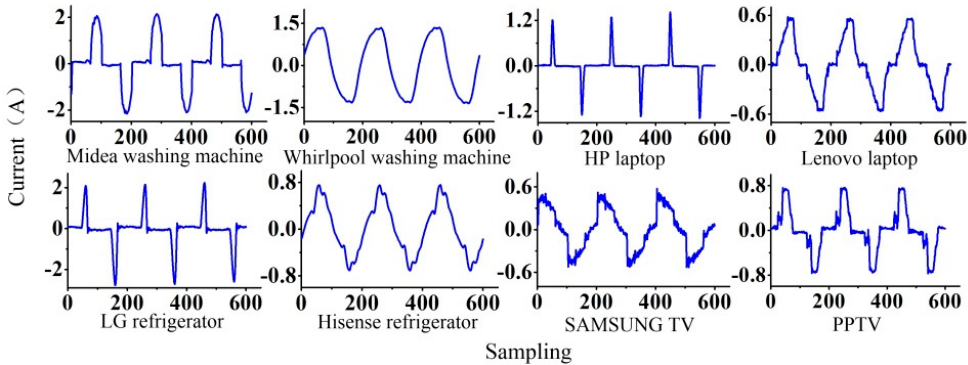
Figure 1. Current waveforms of different categories of electrical appliances with the same load.